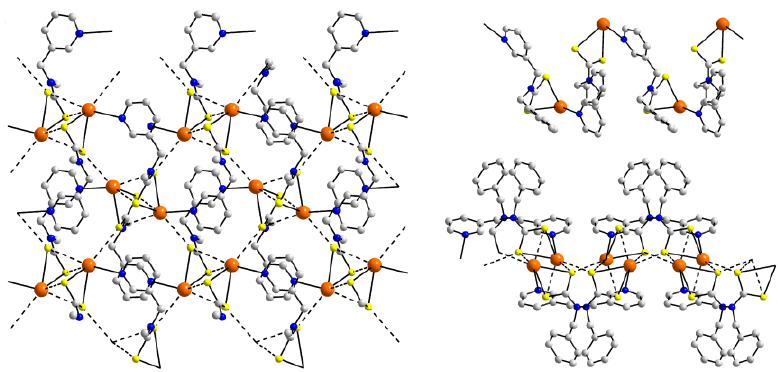
Figure 19. Views of the two-dimensional array in the crystal of [Tl(L 1 )] n ( 54